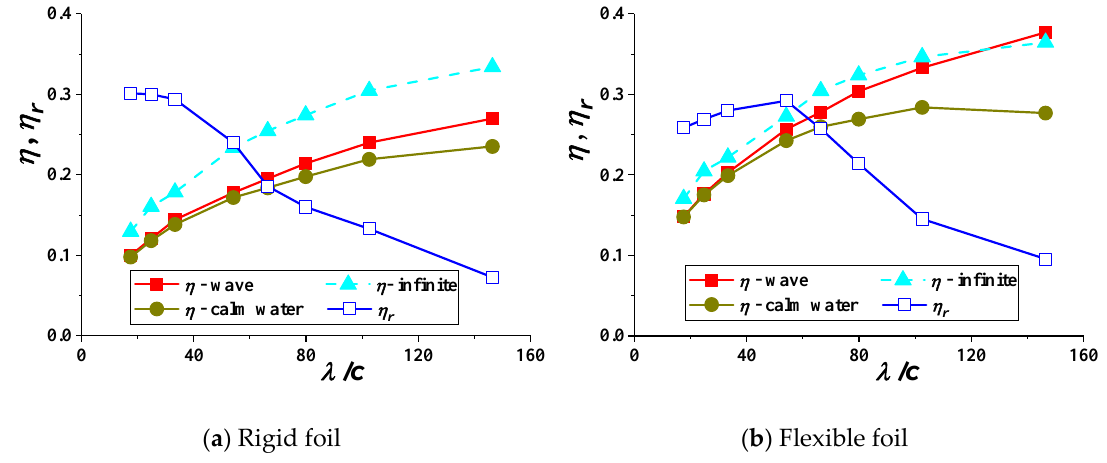
Figure 11. The percentage of wave energy recovery η r and propulsive efficiency η for the foil versus non-dimensional wavelengths.